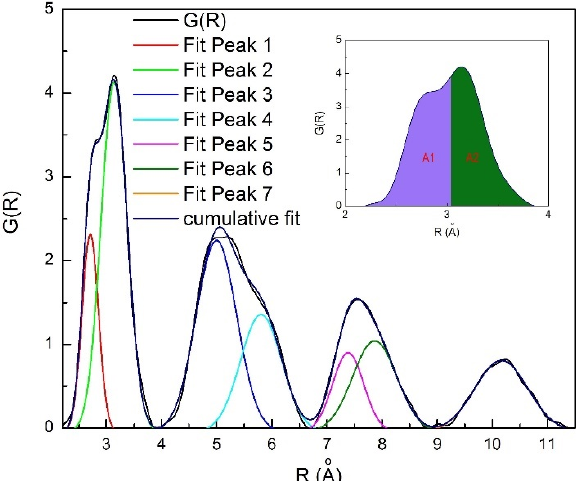
Figure 8. Fitting of four G(R) maxima (black curve) of the Zr 55 Cu 30 Ni 5 Al 10 glass-forming alloy from 0.23 to 1.15 nm obtained at 501 K using seven Gaussian functions related to P1–P7 (as indicated) reproduced from Ref. [152] with permission of Elsevier (copyright year 2020, copyright owner Elsevier). The baseline was subtracted. The value at which two areas A1 and A2 (purple and green) are equal ( R i50 ) is shown in the inset.